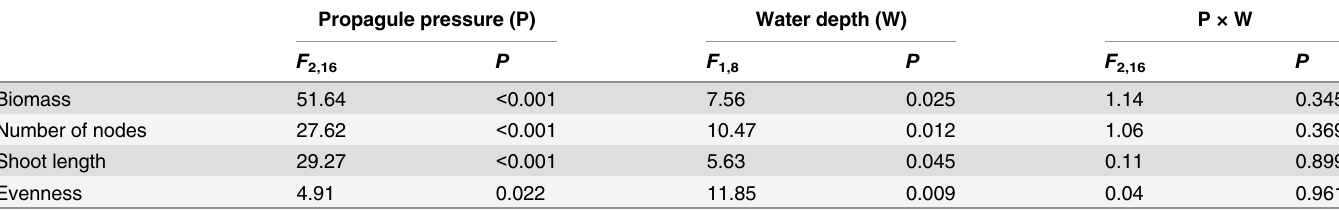
Table 1. Effects of propagule pressure and water depth on the growth and evenness of the submerged communities.